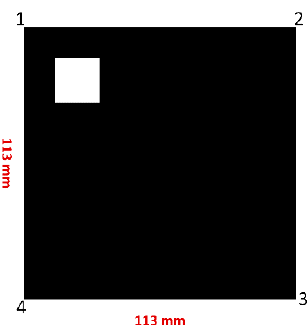
Figure 2. Marker properties. Figure 2. Marker